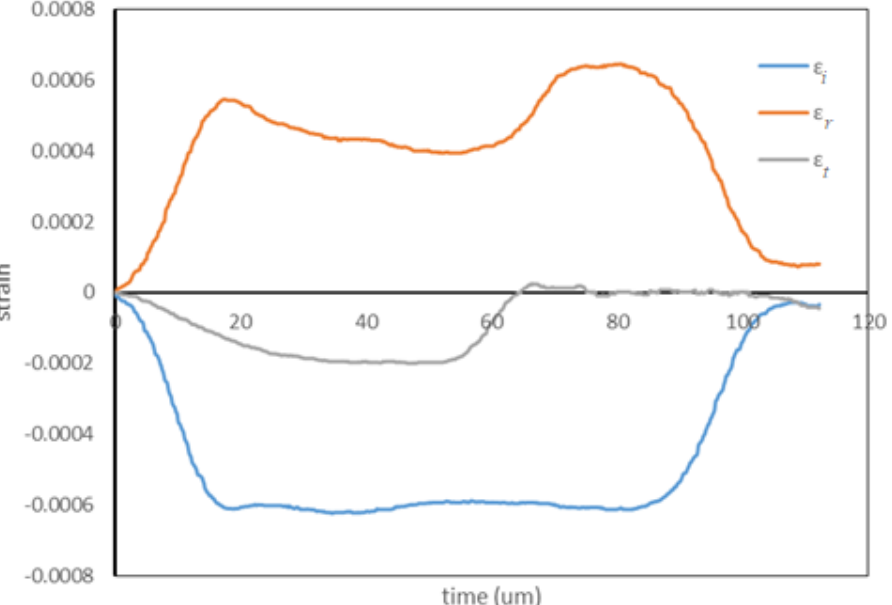
Figure 5. Split Hopkinson pressure bar (SHPB) wave signal for the NSSS sample.